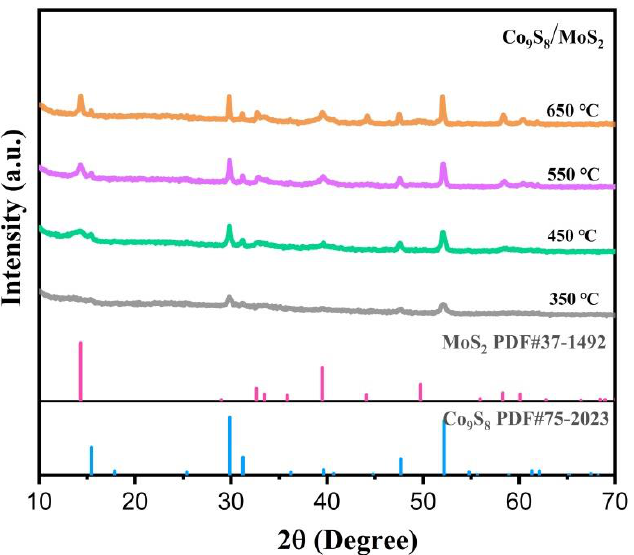
Figure 3. XRD patterns of Co 9 S 8 /MoS 2 after vulcanization of CoMo-LDH at different temperatures.